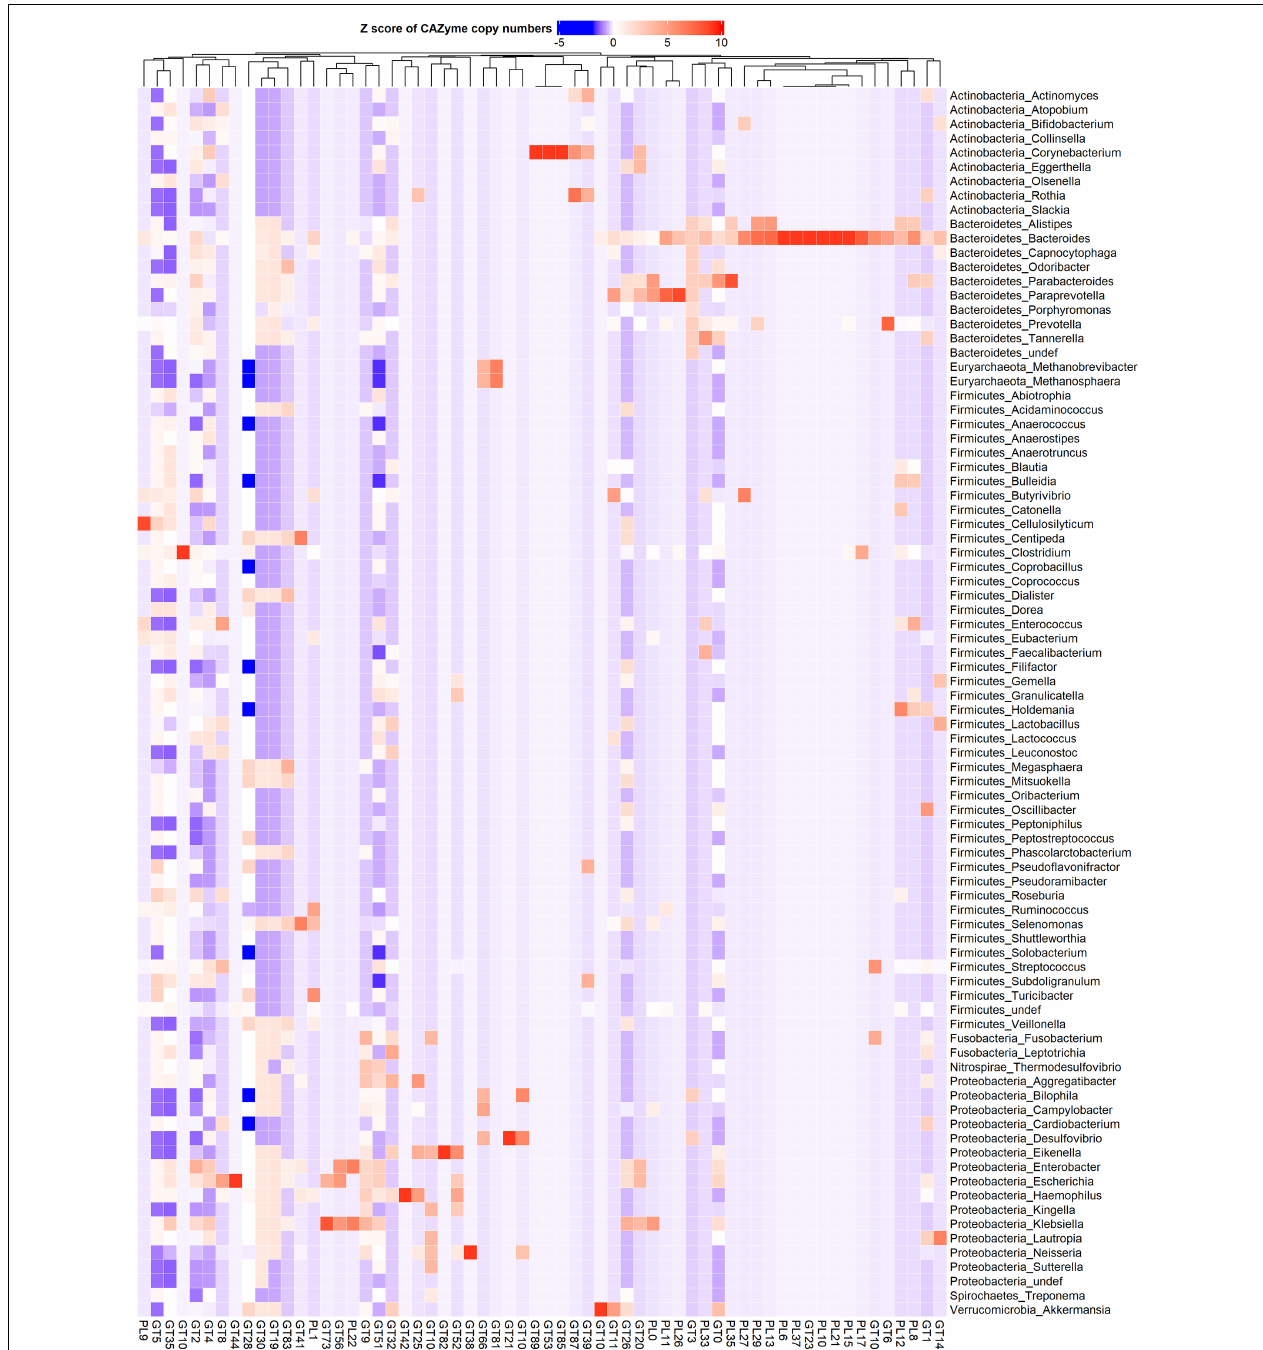
FIGURE 3 | Phylum and genus-specific CAZyme family signatures based on Z score standardization. A heatmap of CAZyme family total gene copy number annotated from 310 reference genomes in 935 metagenomes obtained from the oral (saliva) and gut (fecal) samples of healthy subjects, as well as patients suffering from type 1 diabetes, colorectal cancer, and rheumatoid arthritis. A total of 43 distinct glycosyltransferases (GTs) and 19 polysaccharide lyases (PLs) from nine phyla and 86 genera are